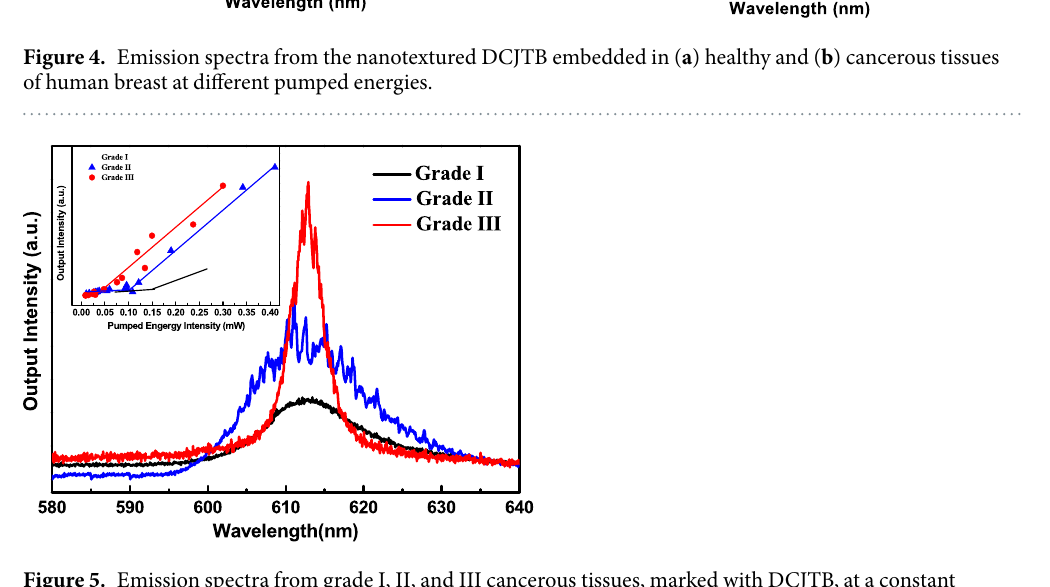
Figure 5. Emission spectra from grade I, II, and III cancerous tissues, marked with DCJTB, at a constant pumped intensity of 0.15